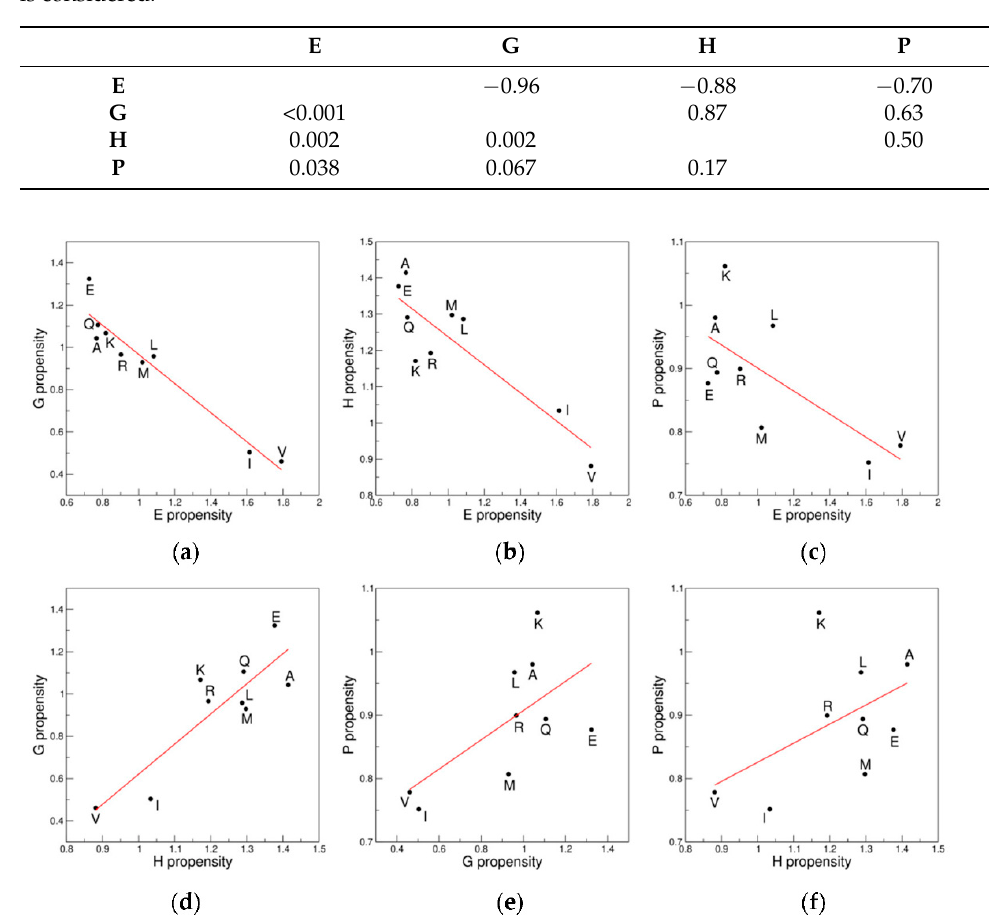
Table 4. Pair-wise comparison of the propensity scales for the secondary structure elements ( α -helix (H), 3 (10)-helix (G), β -sheet (E), and polypropline II (P)). The correlation coefficients R and the p -values are reported on the right and left side of the diagonal, respectively. The 9AA ensemble is considered.